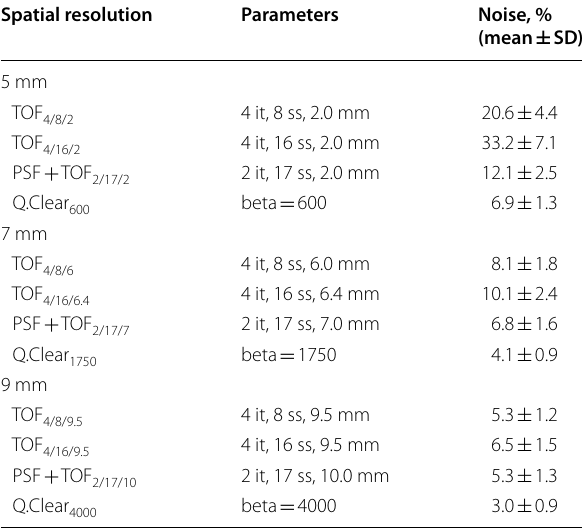
Table 1 Reconstruction parameters and image